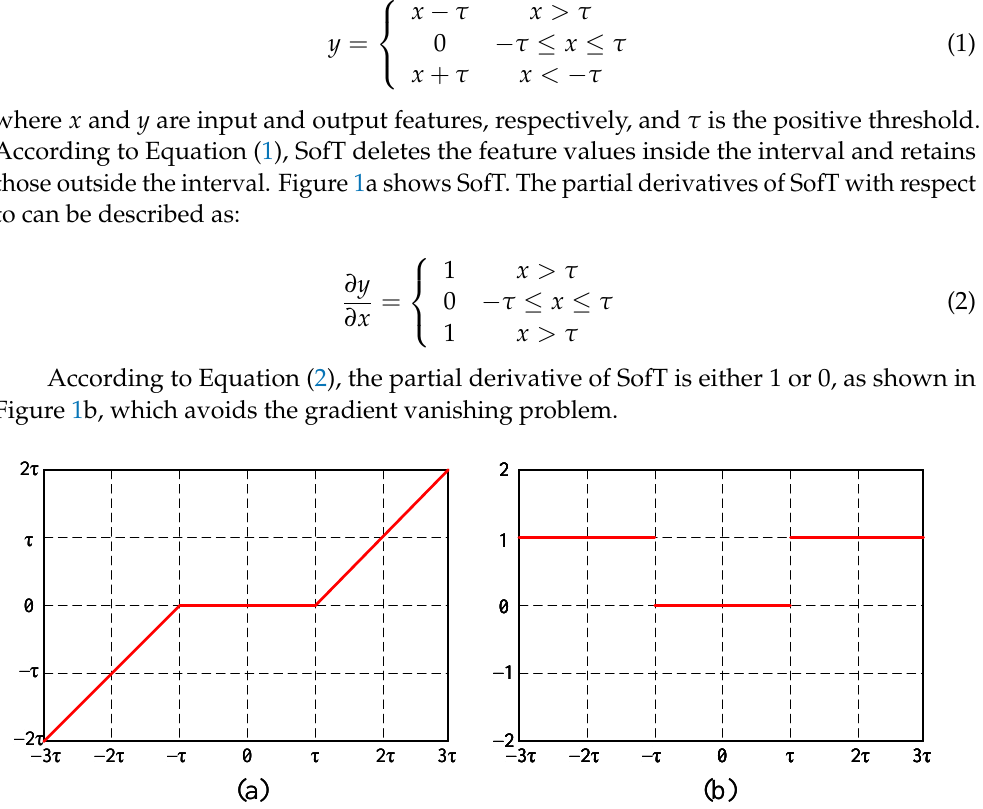
Figure 1. ( a ) Soft thresholding function, ( b ) soft thresholding function partial